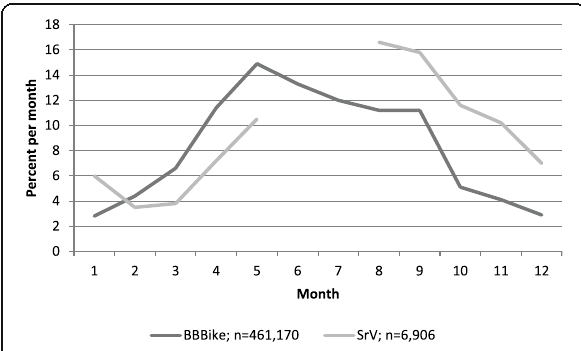
Fig. 4 Distribution of BBBike requests over the course of the year compared with SrV. In SrV, trip data are not collected during summer